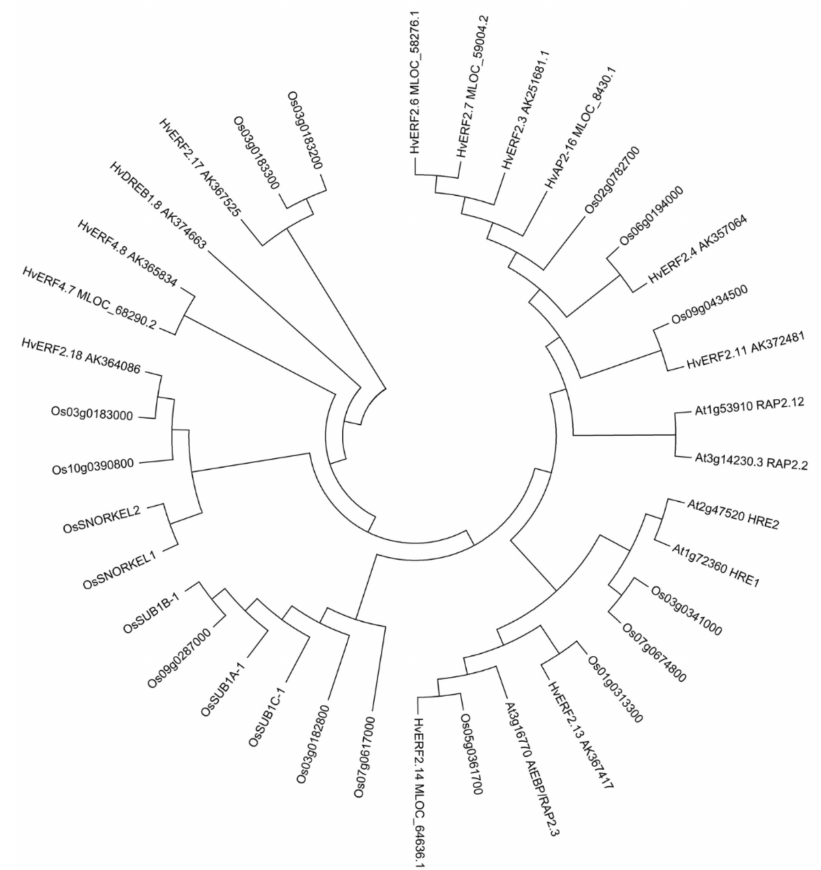
Figure 3. Phylogenetic tree of ERF TFs with conserved N-terminal motif (MCGGAI / L) in Arabidopsis, rice and barley. The phylogenetic tree was constructed by the neighbor-joining method. The numbers on the nodes indicate bootstrap values from 1000